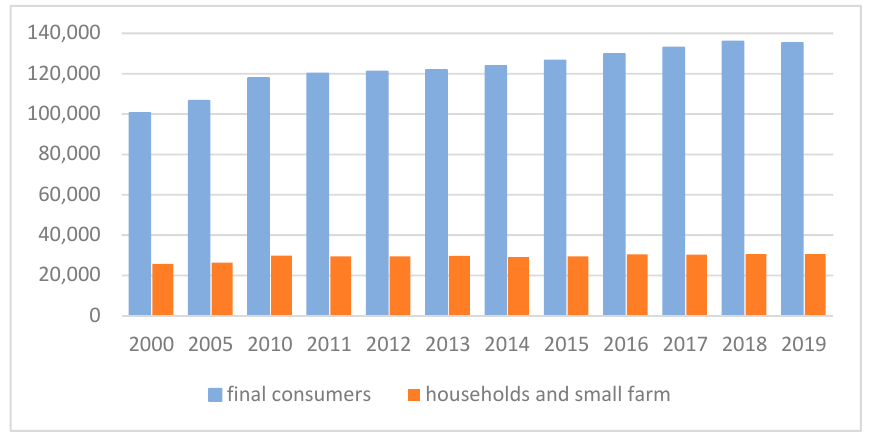
Figure 1. The supply of electricity to final consumers in Poland (in GWh).